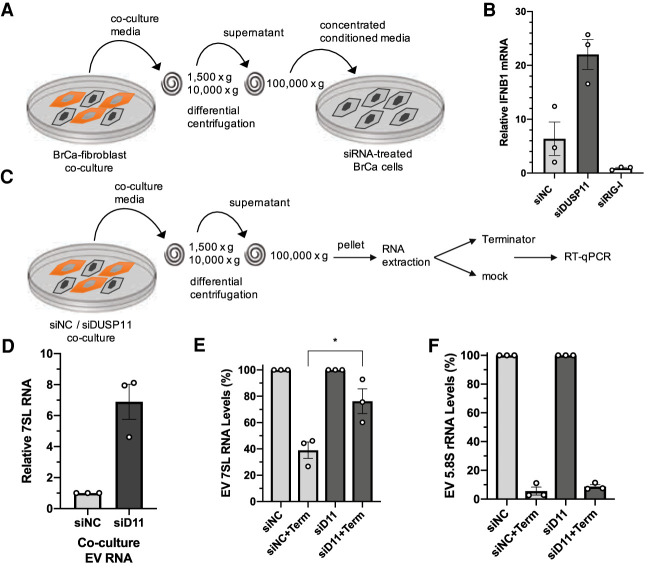
Reducing DUSP11 increases 7SL RNA 5′-triphosphate levels in tumor-fibroblast extracellular vesicles. (A) Schematic diagram of the coculture conditioned media transfer assay. EV-containing conditioned media was concentrated from coculture media by differential centrifugation and transferred to MDA-MB-231 breast cancer (BrCa) cells silenced for DUSP11 or RIG-I. (B) RT-qPCR analysis of IFNB1 mRNA in siRNA-treated MDA-MB-231 cells incubated in concentrated coculture conditioned media as in A. Results are presented relative to those of untreated mock MDA-MB-231 cells. (C) Schematic diagram of the 5′ end characterization RT-qPCR assay of 7SL RNA isolated from coculture EVs. EV-containing pellets were collected from coculture conditioned media by differential centrifugation. Extracted RNA was treated with DNase I followed by treatment with or without 5′-monophosphate-specific exonuclease Terminator. (D) RT-qPCR analysis of 7SL RNA in EV RNA extracted from siNC or siDUSP11 (siD11) cocultured conditioned media. Results are presented relative to siNC coculture with 5S rRNA as the endogenous control. (E) RT-qPCR analysis of 7SL RNA in EV RNA isolated from siNC or siDUSP11 (siD11) cocultured conditioned media, treated with or without Terminator. Results are presented relative to mock-treated siNC coculture with 5S rRNA as endogenous control. (F) RT-qPCR analysis of 5.8S rRNA in EV RNA isolated from siNC or siDUSP11 (siD11) cocultured conditioned media, treated with or without Terminator. Results are presented relative to mock-treated siNC coculture with 5S rRNA as endogenous control. Data are derived from n = 3 independent replicates in B and D–F. In all panels, data are presented as mean ± SEM. (*) P < 0.05 (two-tailed Student's t-test).